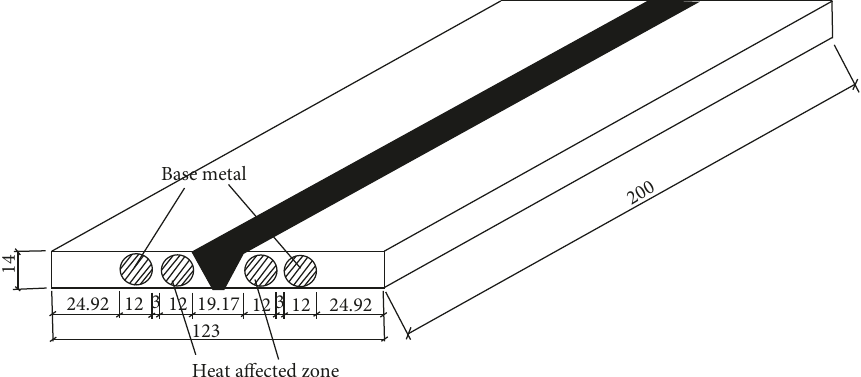
Figure 2: Specimens of butt-welded plate.